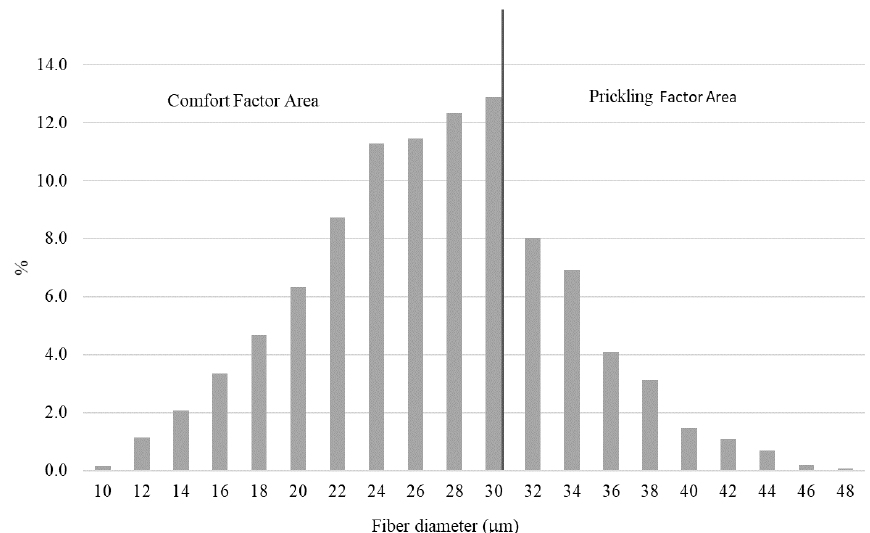
Figure 2. The distribution of the fiber diameter in the wool of the alpacas tested.